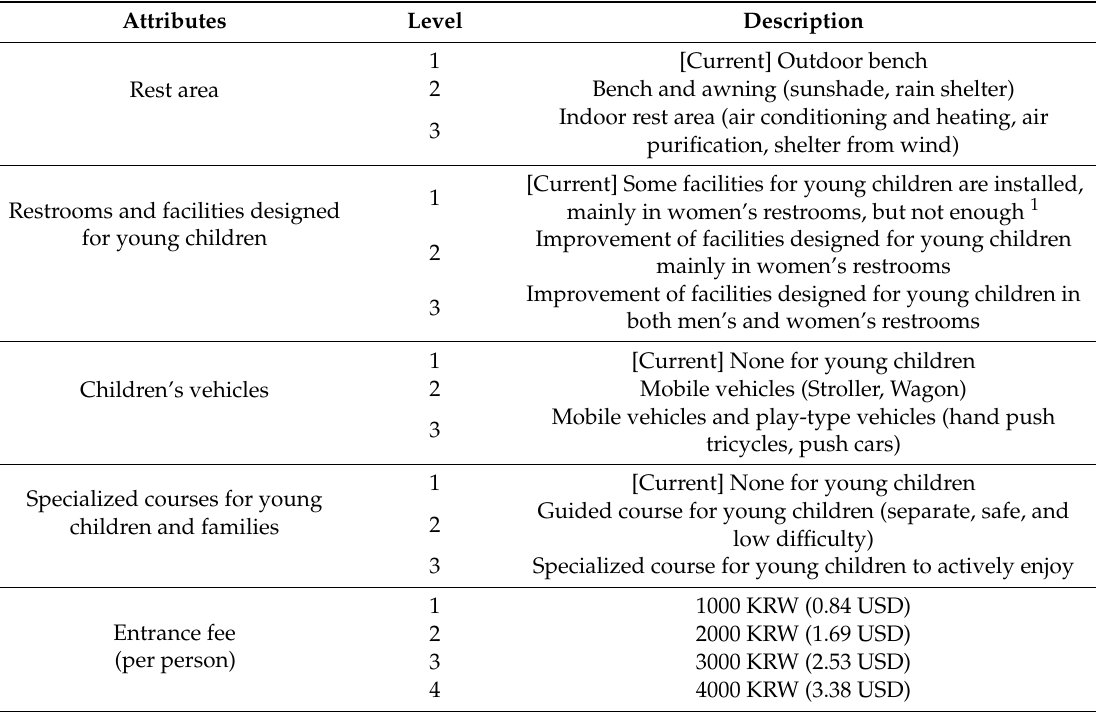
Table 1. Attributes and levels for the Choice